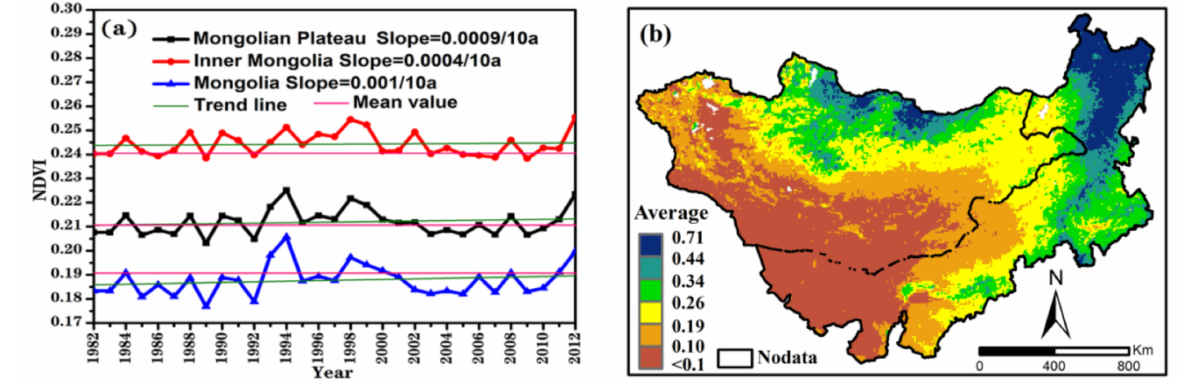
Figure 6. Variation in vegetation on the Mongolian Plateau from 1982 to 2012; ( a ) the temporal change in the normalized difference vegetation index (NDVI) and ( b ) spatial distribution of multi-year mean variation in NDVI.